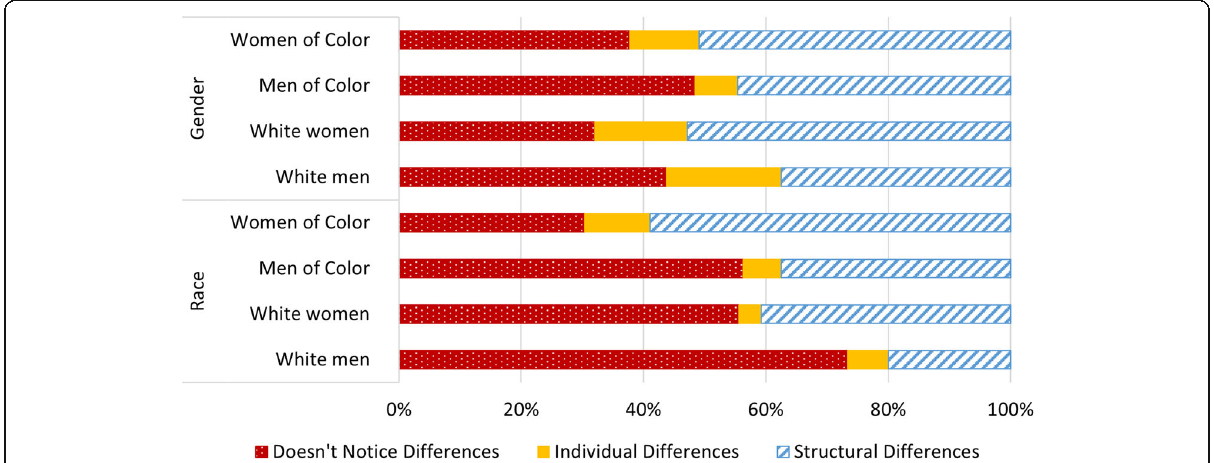
Fig. 7 Overall distribution of responses to the question of whether there are differences in experiences due to gender and race. Structural differences refer to racism/sexism